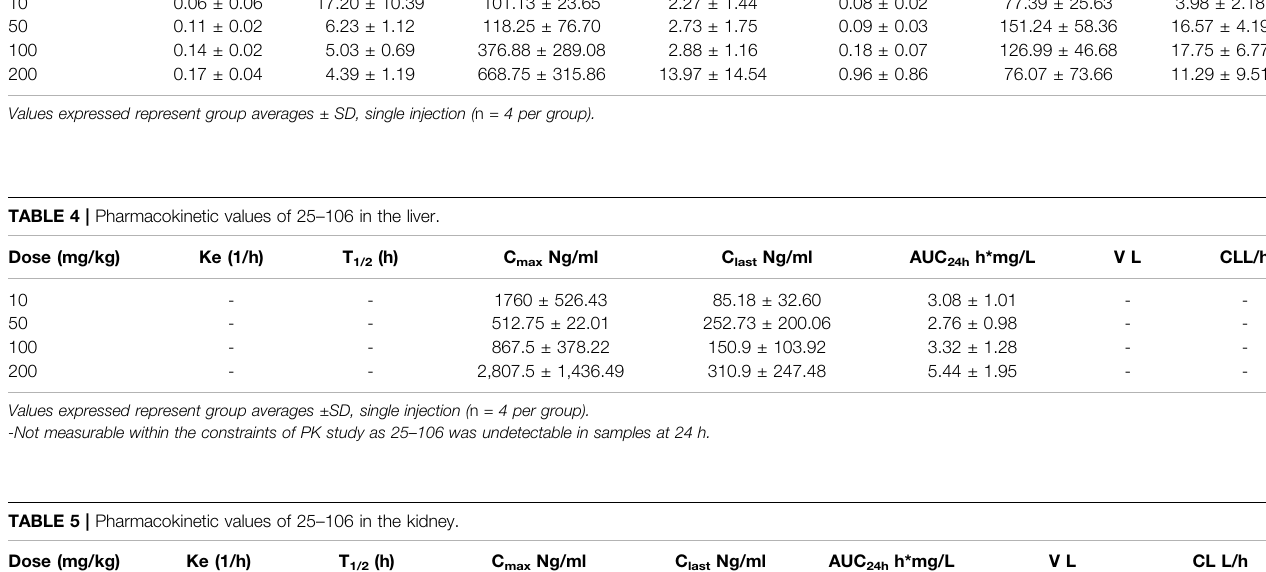
TABLE 3 | Pharmacokinetic values of 25 – 106 in the brain. Dose (mg/kg)